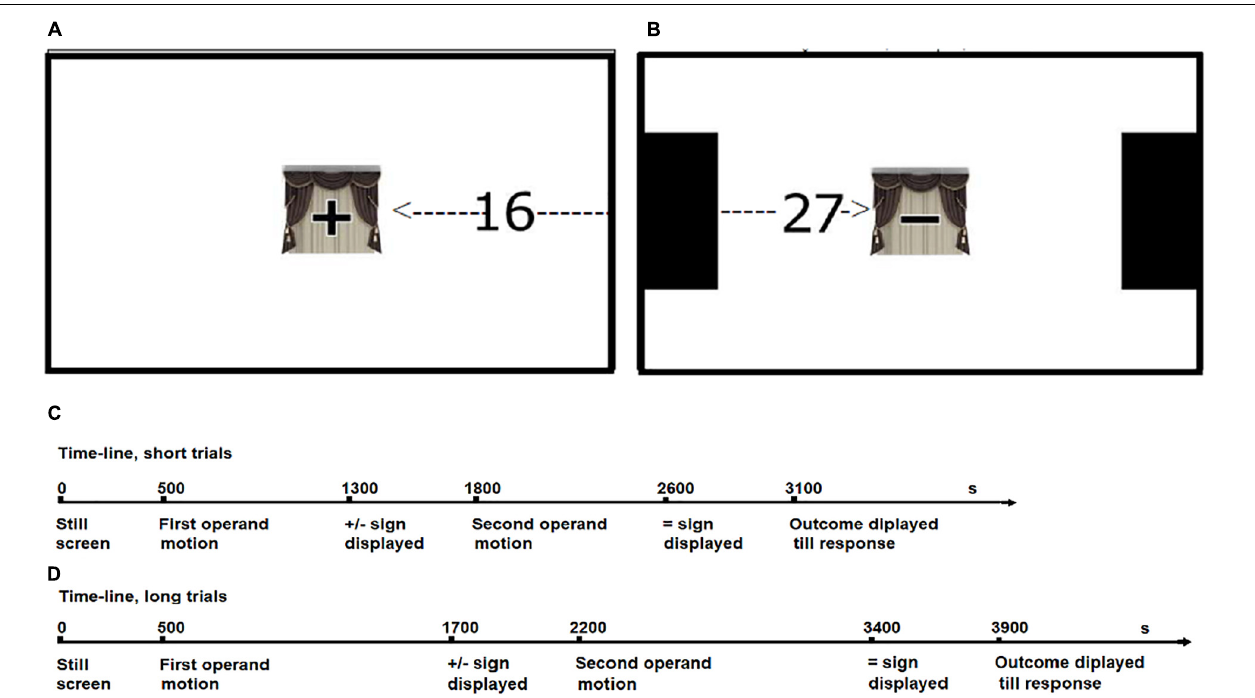
FIGURE 1 | The trial layout and time-line. The dashed line with an arrow shows the path and direction of movement. (A) Screen layout, addition, long distance, and leftward motion. (B) Screen layout subtraction, short distance, and rightward motion. (C) Trial time-line of short-duration events. (D) Trial time-line of long-duration